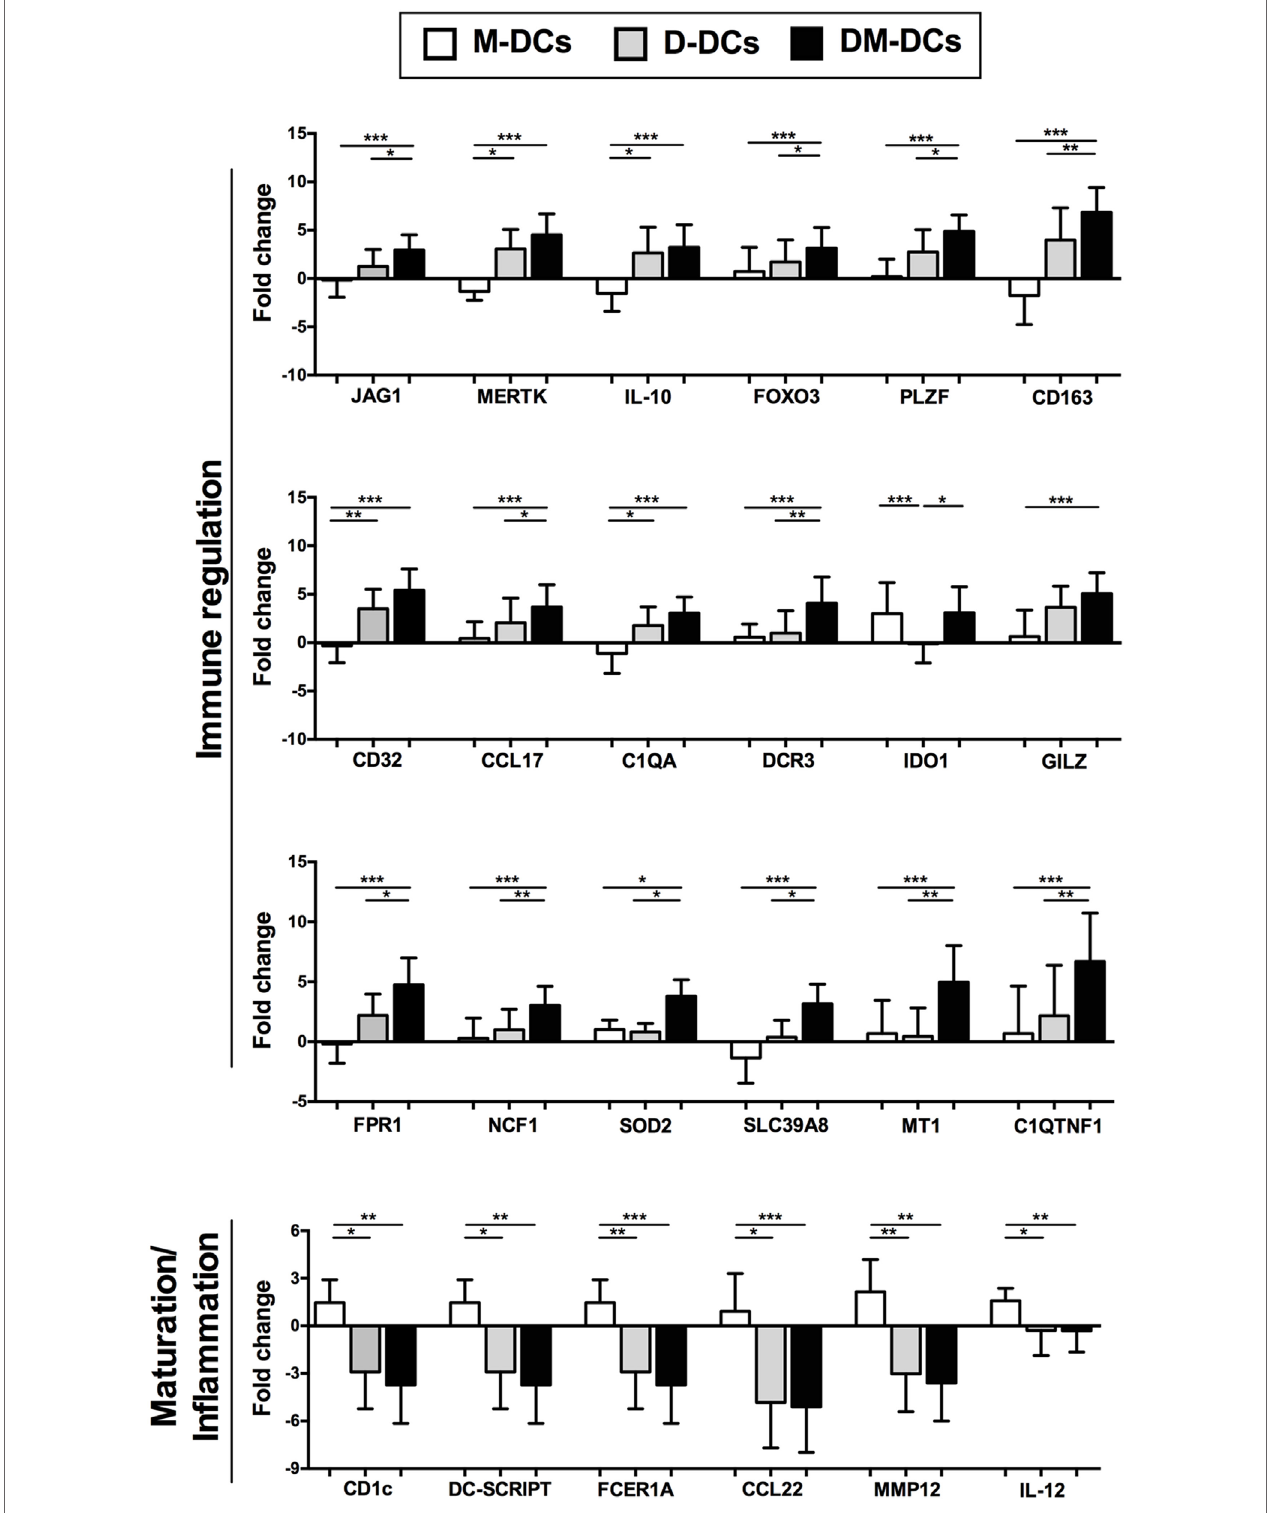
FigUre 5 | Dexamethasone-modulated and monophosphoryl lipid A (MPLA)-activated dendritic cells (DM-DCs) show upregulation of tolerance-related genes and downregulation of genes involved in maturation and inflammatory response. Gene expression levels of differentially expressed genes modulated by dexamethasone and MPLA in DM-DCs was confirmed by real time PCR. Results are shown as Fold Change values with respect to the untreated control (DCs). Data represent mean ± SD for 10 independent experiments. * p -value ≤ 0.05; ** p -value ≤ 0.01; *** p -value ≤